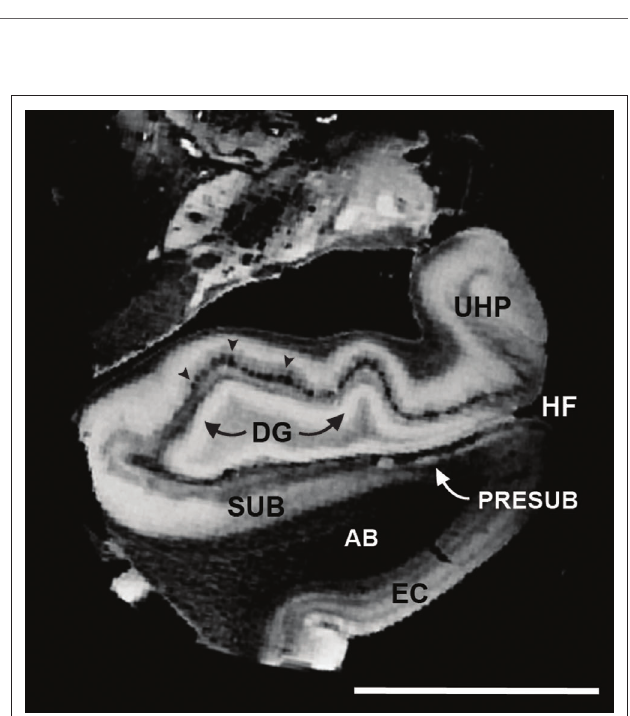
Figure 5 | isotropic 100 μm FLASH image that illustrates the anatomical areas that make up the perforant pathway: eC > AB > SuB/ PreSuB > terminal zone of the perforant pathway in the dentate and HP (i.e. molecular layer; black arrowheads). Magnification bar = 1